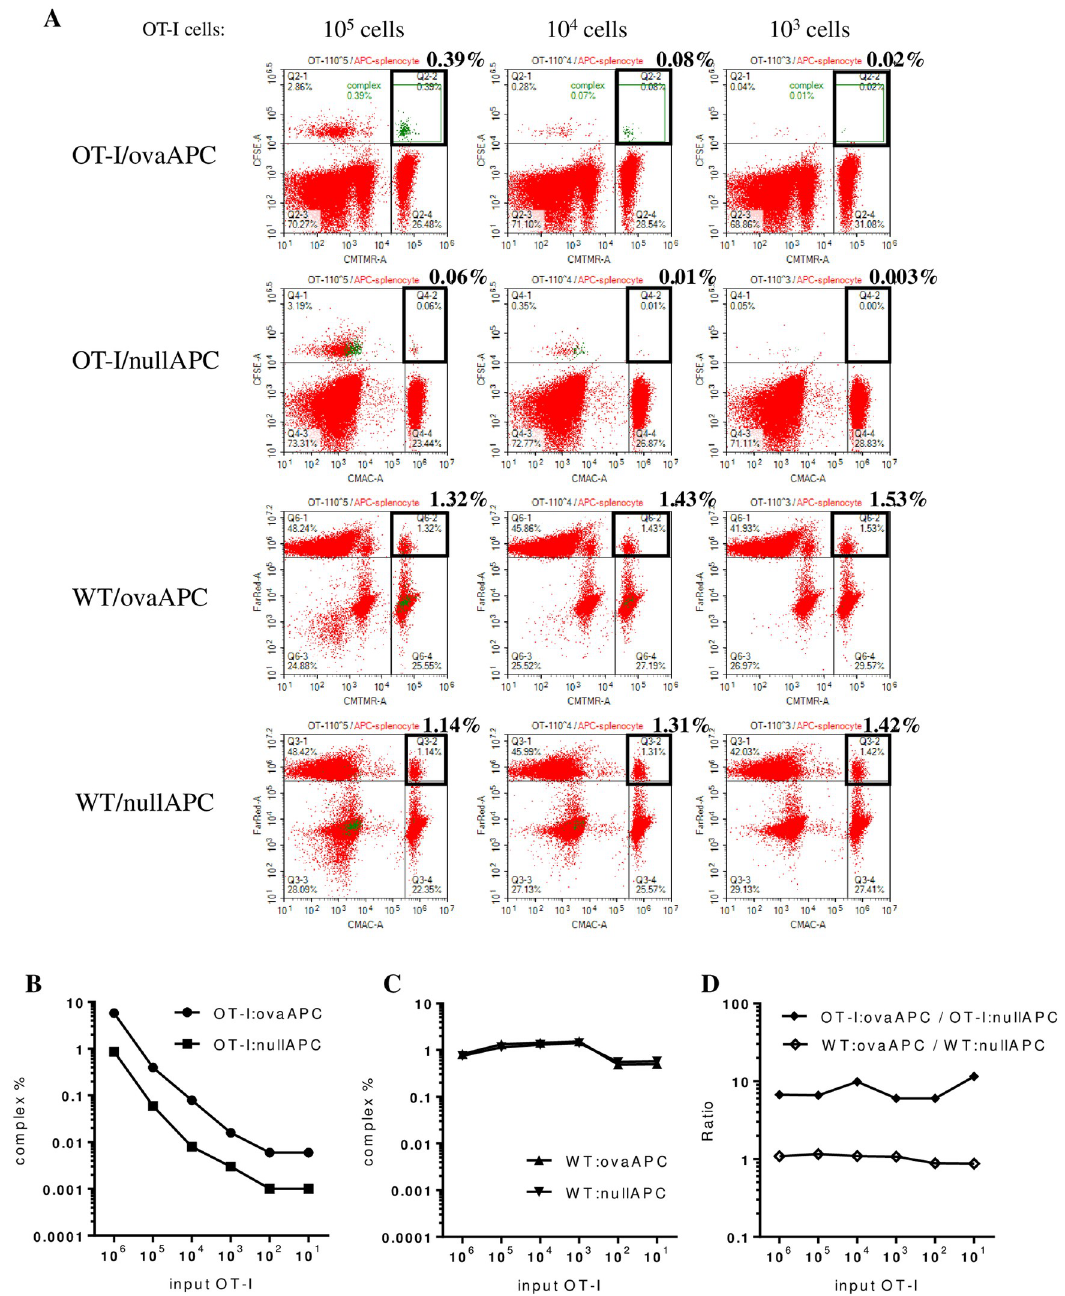
Fig 2. OT-I/ovaAPC complexes were more frequently observed than OT-I/nullAPC complexes, in a broad range of available OT-I cell numbers. (A) OT-I, ovaAPC, WT, and nullAPC were mixed as described in Fig 1, but only the OT-I cell numbers were serially decreased from 10 6 –10 1 , while the other cell number were kept constant at 10 6 , followed by analysis of each cellular complex formation as described in Fig 1. This figure shows only the panels for 10 5 , 10 4 , and 10 3 cells. (B) Line graphs for the frequencies of OT-I/ovaAPC and OT-I/nullAPC complexes were plotted for input OT-I numbers from 10 6 to 10 1 . In all the examined conditions, OT-I/ovaAPC complexes were 6 to 10 times more frequent than OT-I/nullAPC complexes. (C) Line graphs for the frequencies of WT/ovaAPC and WT/nullAPC complexes were plotted for input OT-I numbers from 10 6 to 10 1 . (D) Line graph of the ratio between OT-I/ovaAPC and OT-I/nullAPC. All the data in this figure is representative of two independent experiment with similar results.